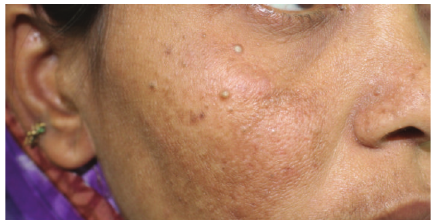
Figure 1: Trichilemmomas on the right malar bone.